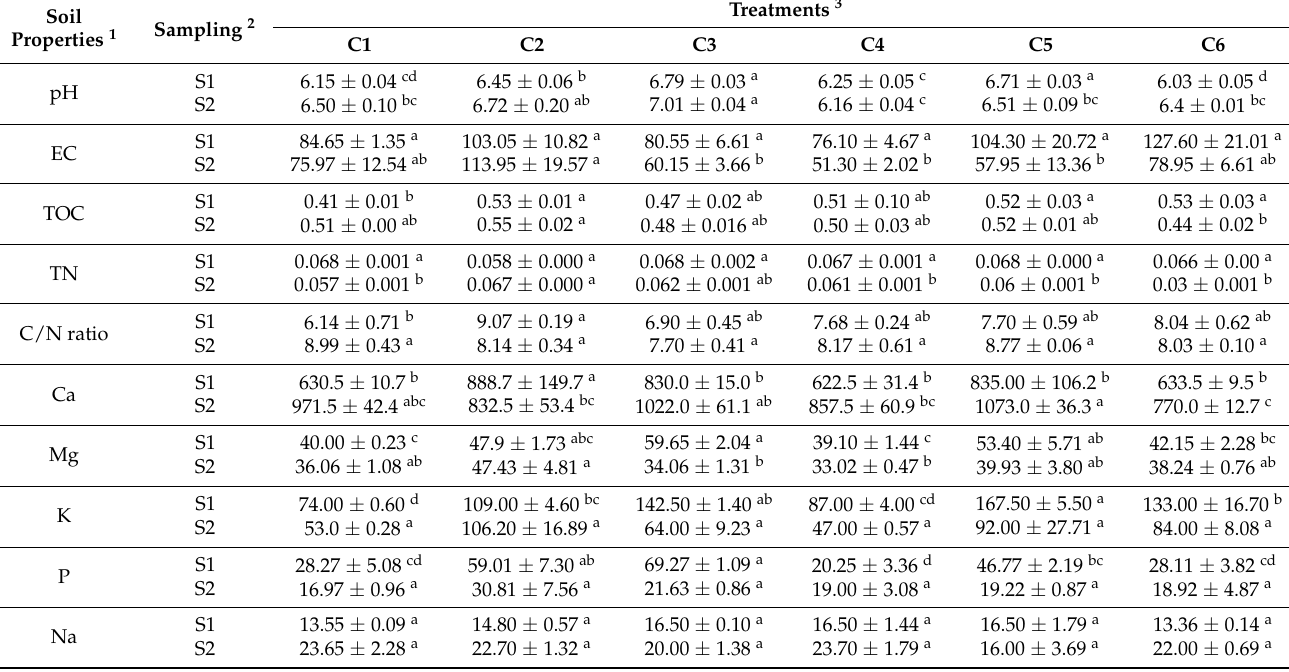
Table 1. The effects of fertilizer and microbial inoculants on soil